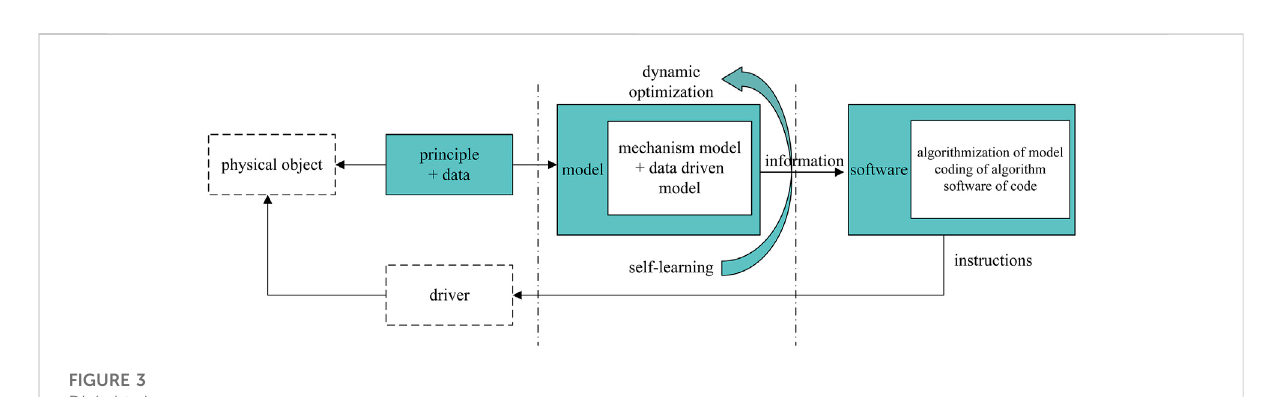
FIGURE 3 Digital